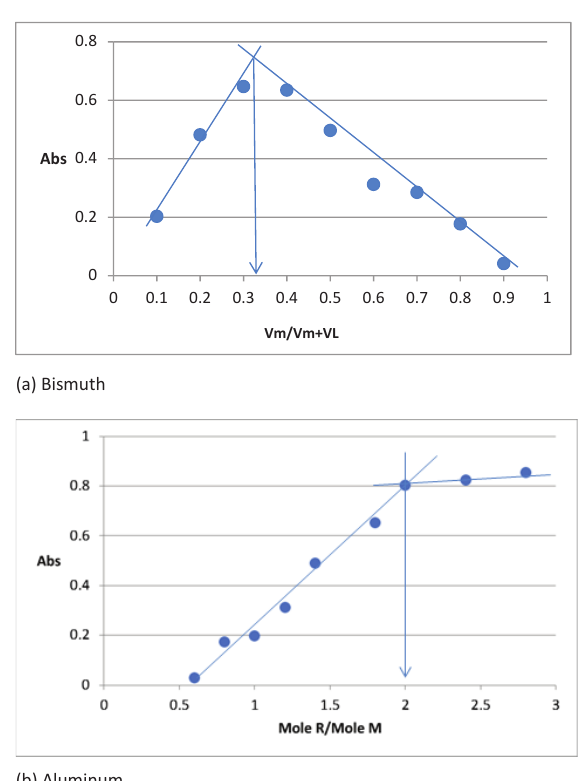
Figure 25: Methods of continuous variations (s) and molar ratio (b) for Al 3+ complex at pH = 6.0.